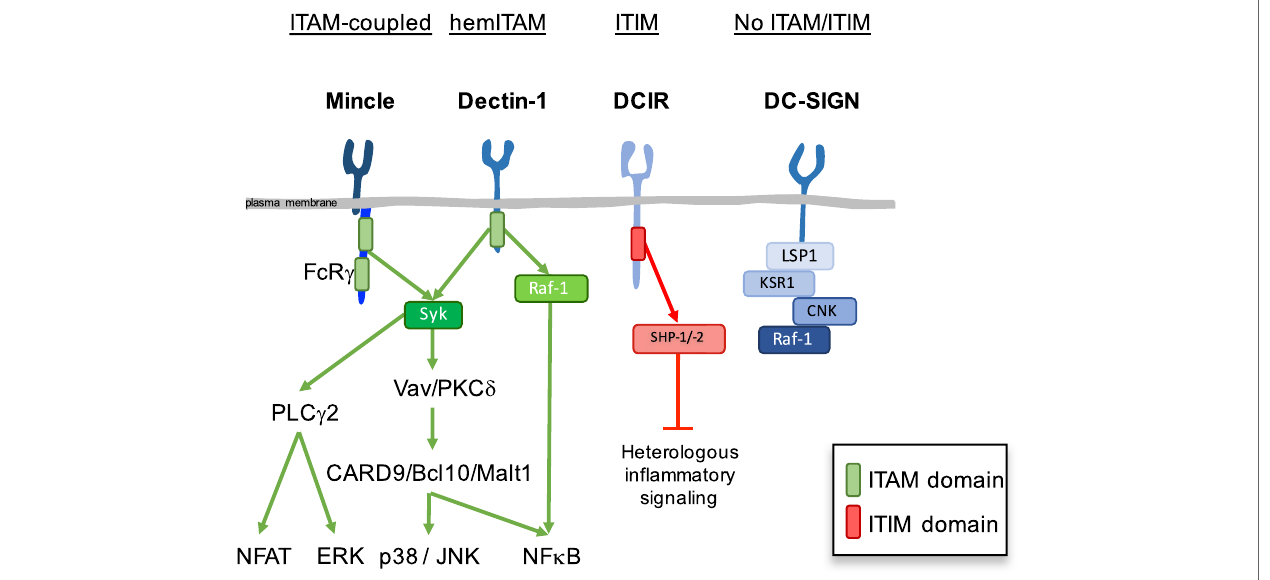
FiGURe 1 | Canonical signaling modules in myeloid C-type lectin receptors (CLRs). Based on canonical intracellular signaling motifs, myeloid CLRs can be classified into immunoreceptor tyrosine-based activating motif (ITAM)-coupled CLRs, hemi-ITAM-(hemITAM)-bearing CLRs, immunoreceptor tyrosine-based inhibitory motif (ITIM)-containing CLRs, and a group of CLRs lacking typical signaling motifs. Mincle, Dectin-1, DCIR, DC-SIGN, and their corresponding canonical signaling pathways and adaptors are depicted as prototypical examples of each